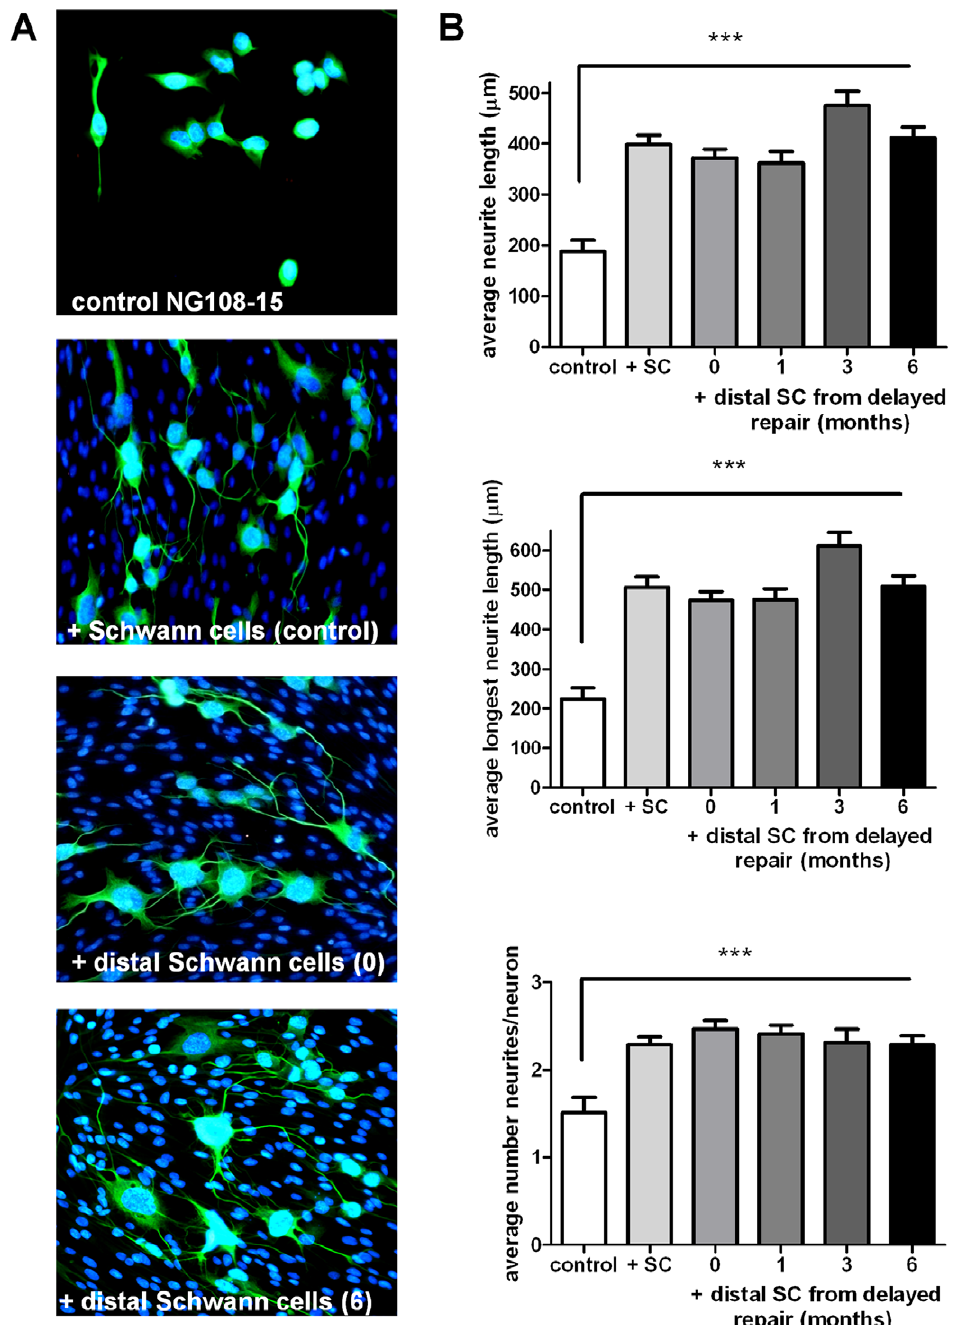
Figure 6. Co-culture of Schwann cells with NG108-15 neurons. (A) NG108-15 cells were either grown alone or on top of a monolayer of Schwann cells isolated from control nerve or distal nerve segments taken from animals undergoing immediate (0) or 6 month delayed nerve repair (6). Cultures were stained with b III tubulin antibody (green) and DAPI (blue). (B) Quantitative analysis of neurite outgrowth was performed on NG108- 15 neurons grown in the absence (control) or presence of Schwann cells isolated from control nerve ( + SC) or distal nerve segments from animals undergoing nerve repair immediately following injury (0) or delayed repair at 1, 3, 6 months. ***P , 0.001 significantly different from values in the absence of Schwann cells. There was no significant difference between any of the cultures in the presence of Schwann cells.